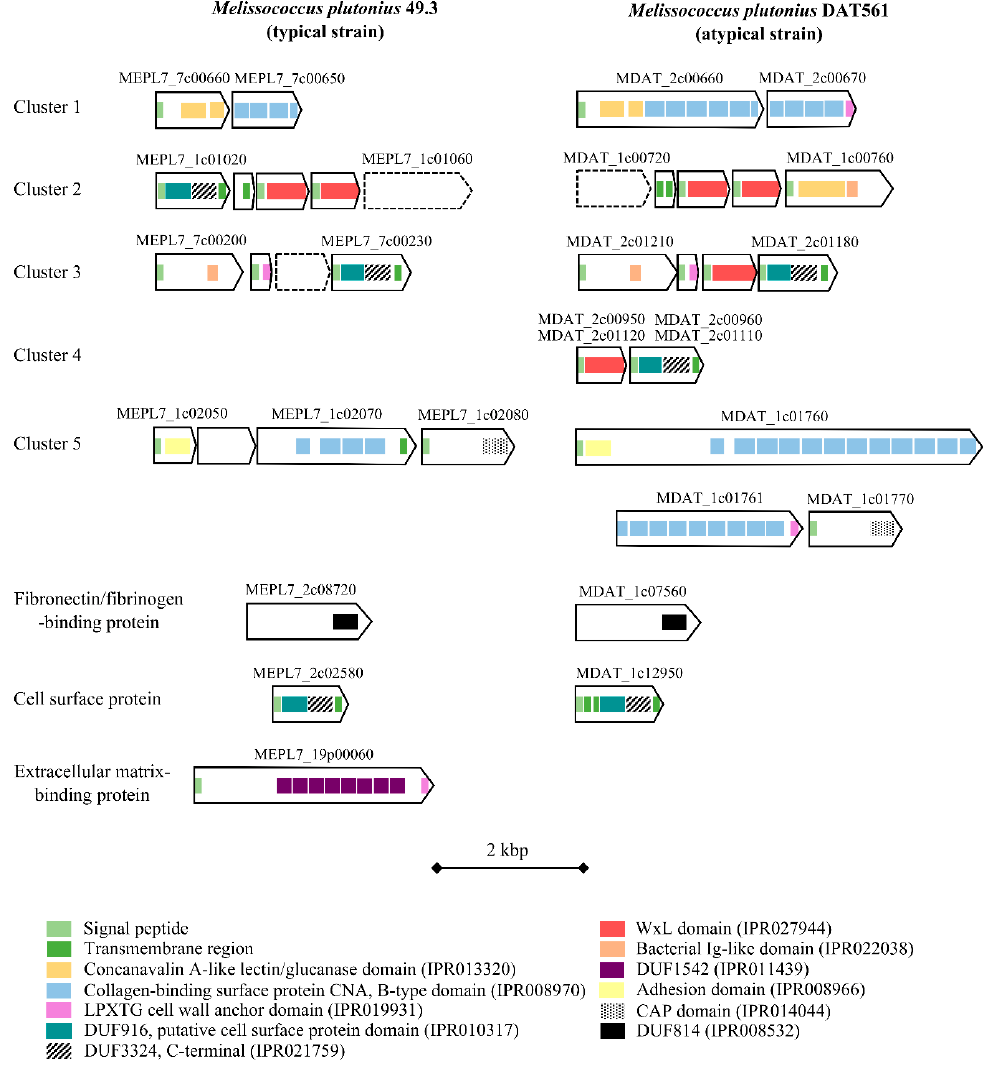
Figure 6. Domain structure of putative bacteria cell surface- and host cell adhesion-associated proteins with a putative role as virulence factors identified in M. plutonius 49.3 and DAT561. Signal peptides, transmembrane regions and domains were determined using InterProScan 5 [21], and are depicted using the color code shown in the legend. Cluster sizes range from 2 to 5.3 kbp in M. plutonius 49.3 and 1.7 kbp to 9.8 kbp in M. plutonius DAT561. The presence of orthologous genes and gene cluster identified in the other strains is shown in Figure 4 and Data S2-Sheet